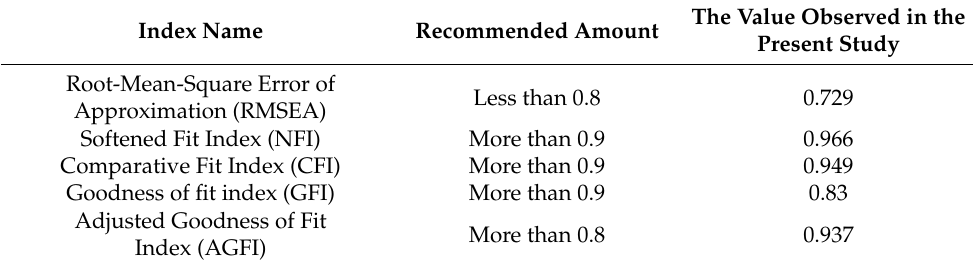
Table 36. Acceptable threshold and observed values of fit indices in the